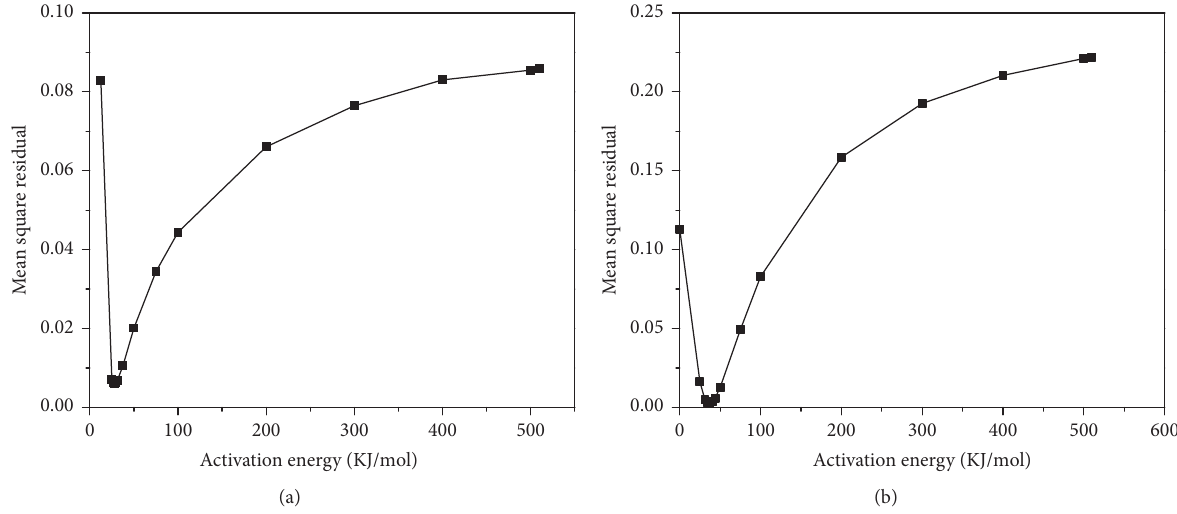
Figure 4: Mean square residual versus apparent activation energy: (a) sintering temperature of 400 ∘ C, pressure of 50 MPa, and holding time of 30 min; (b) sintering temperature of 500 ∘ C, pressure of 50 MPa, and no holding